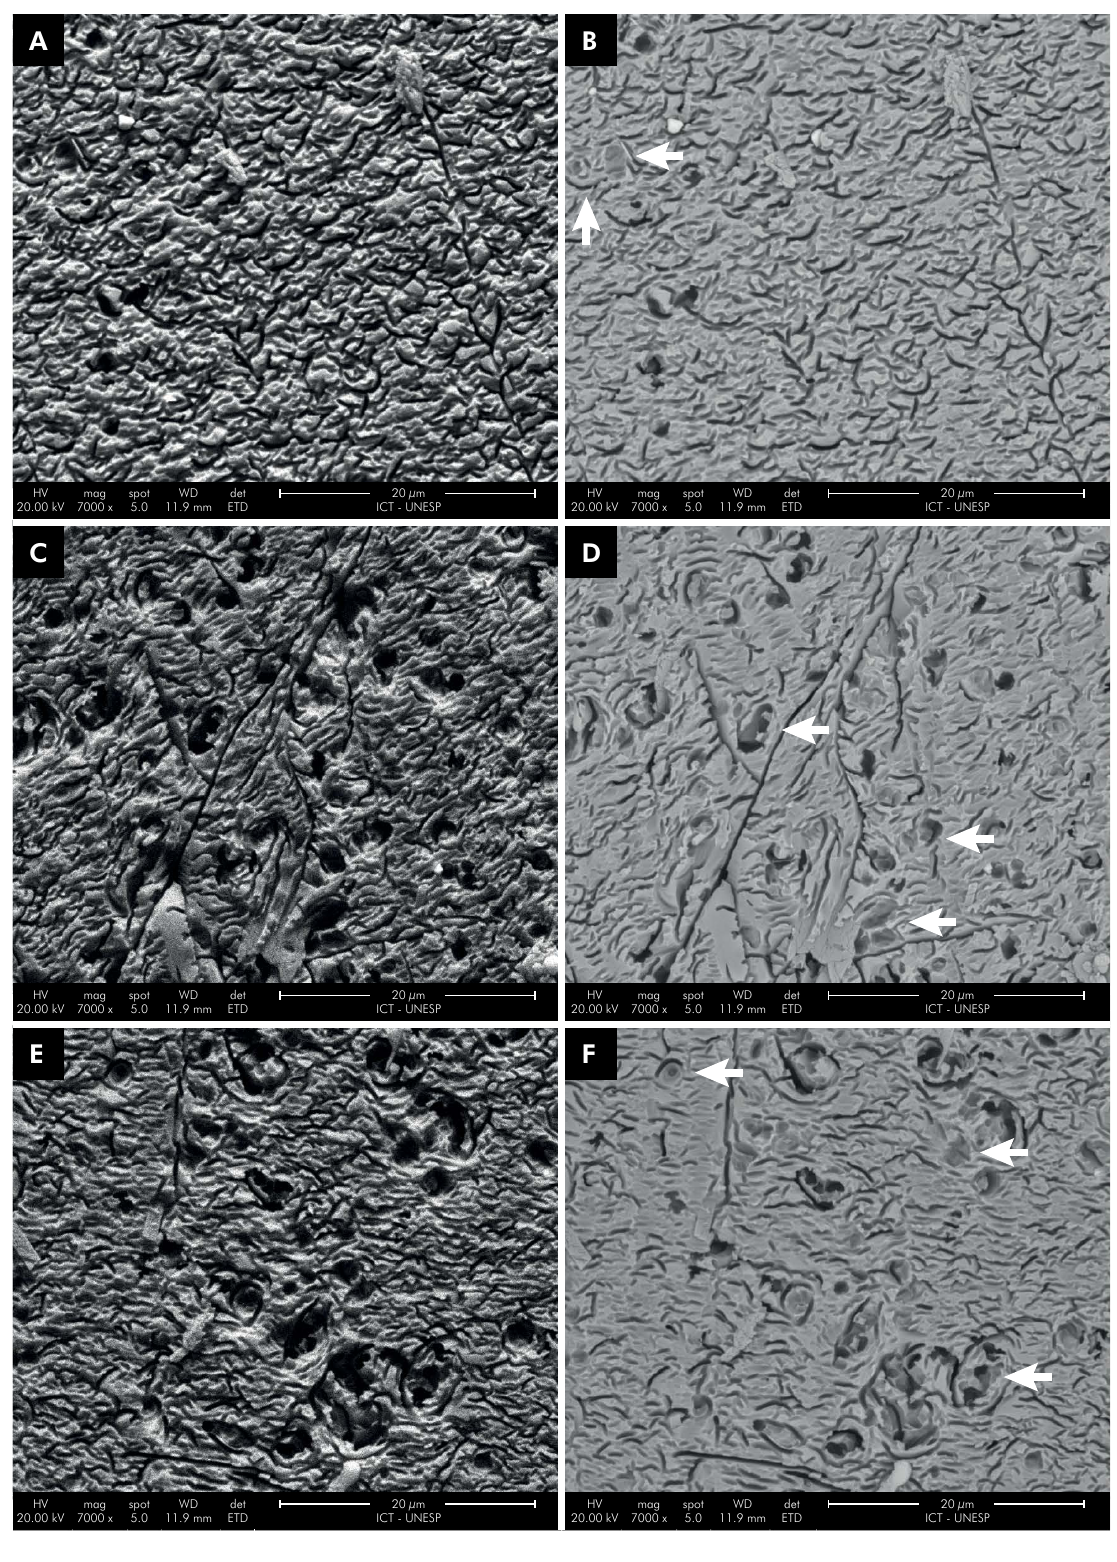
Figure 3. Micrographs (7000x) with secondary electron detectors (ETD - Everhart Thornley Detector) and back-scattered electron detector (BSED) of a representative sample from (A and D) C1, (B and E) C2 and (C and F) C3 groups. White arrows indicate leucite grains.